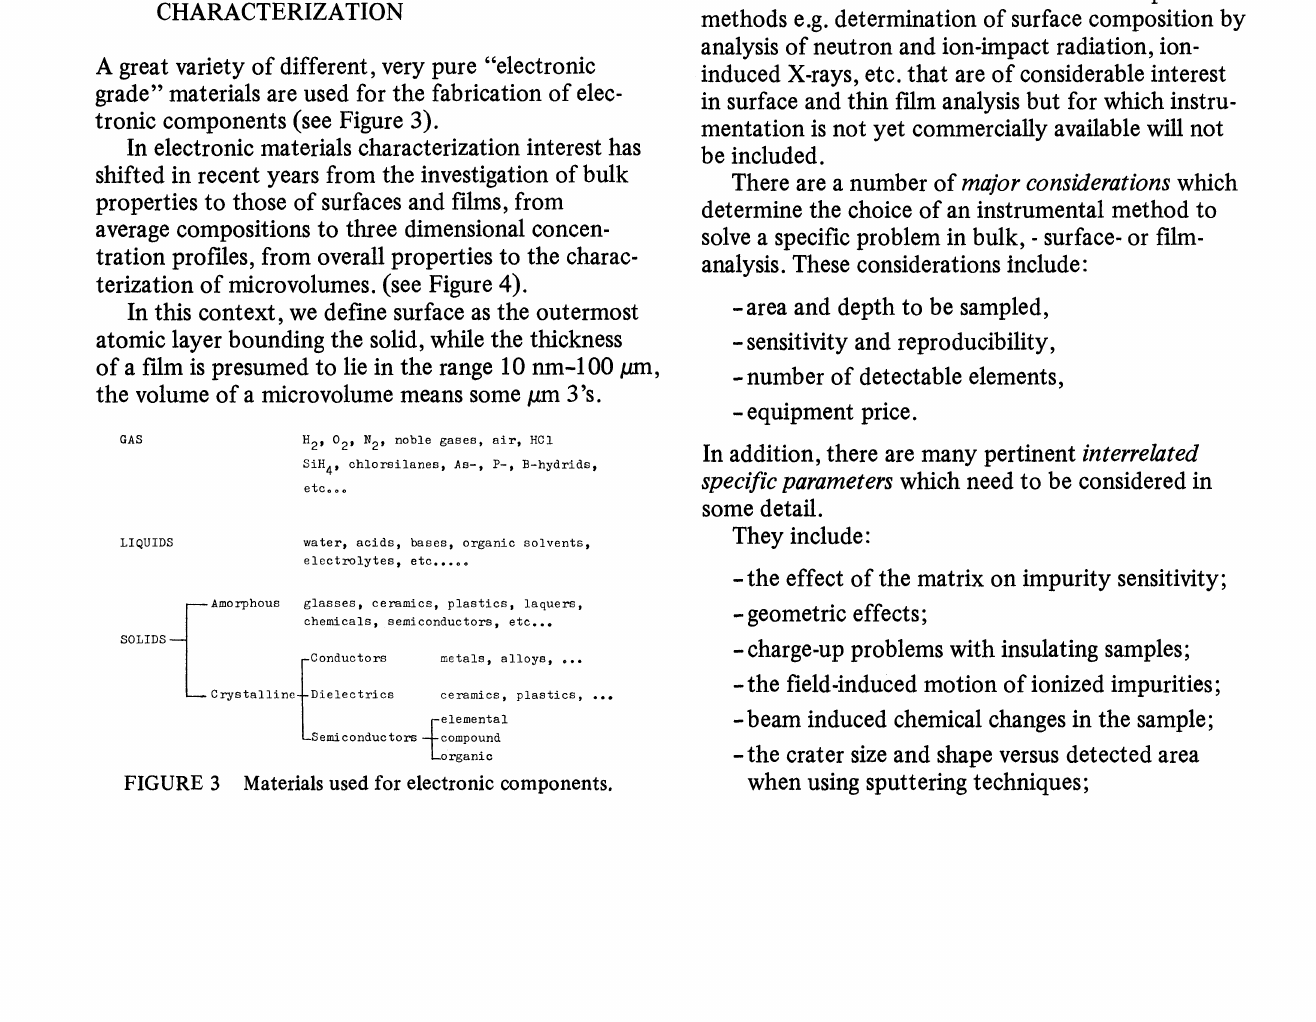
FIGURE 3 Materials used for electronic